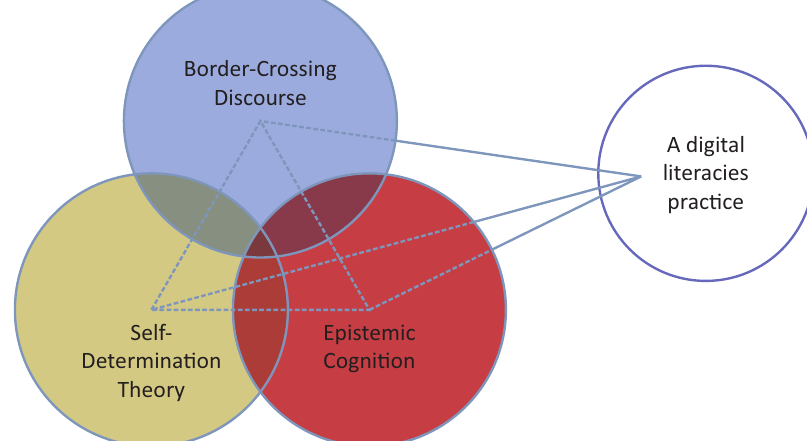
Figure 3. Interconnectedness of the three